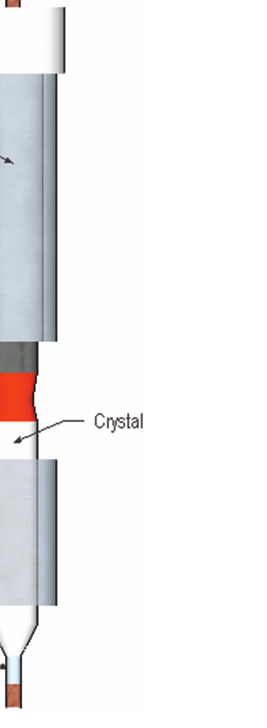
Figure 1: Schematic drawing of the float zone type unidirectional solidification apparatus.